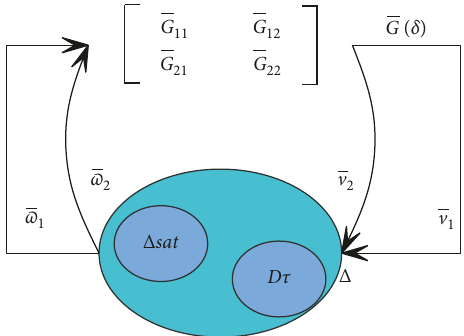
Figure 2: Double closed-loop feedback